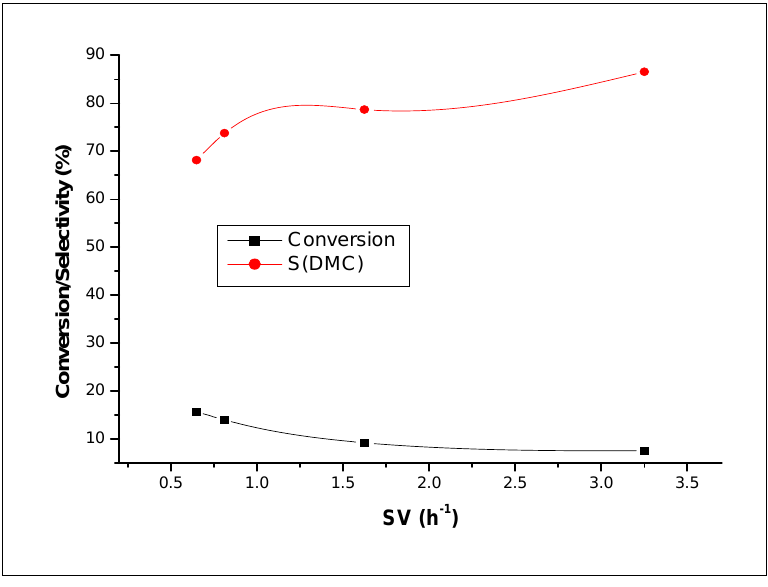
PW O as a function of MWHSV. 1.5 12 40 OH /CO = 3 2